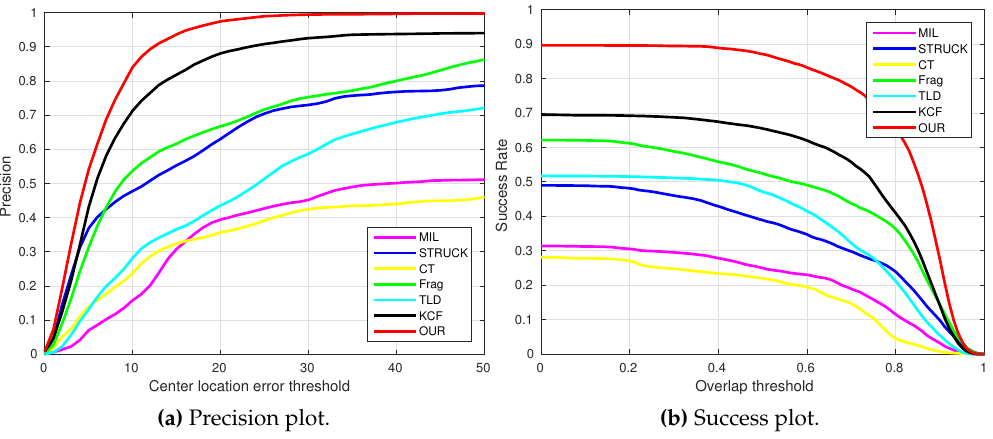
Figure 24. Overall performances of all visual trackers in 11,646 image